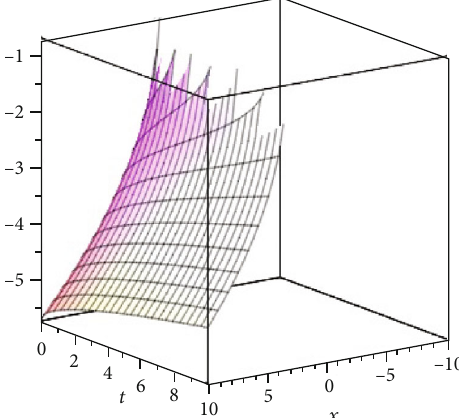
ð x , 0, t Þ of Equation (21). Figure 3: u 1,3